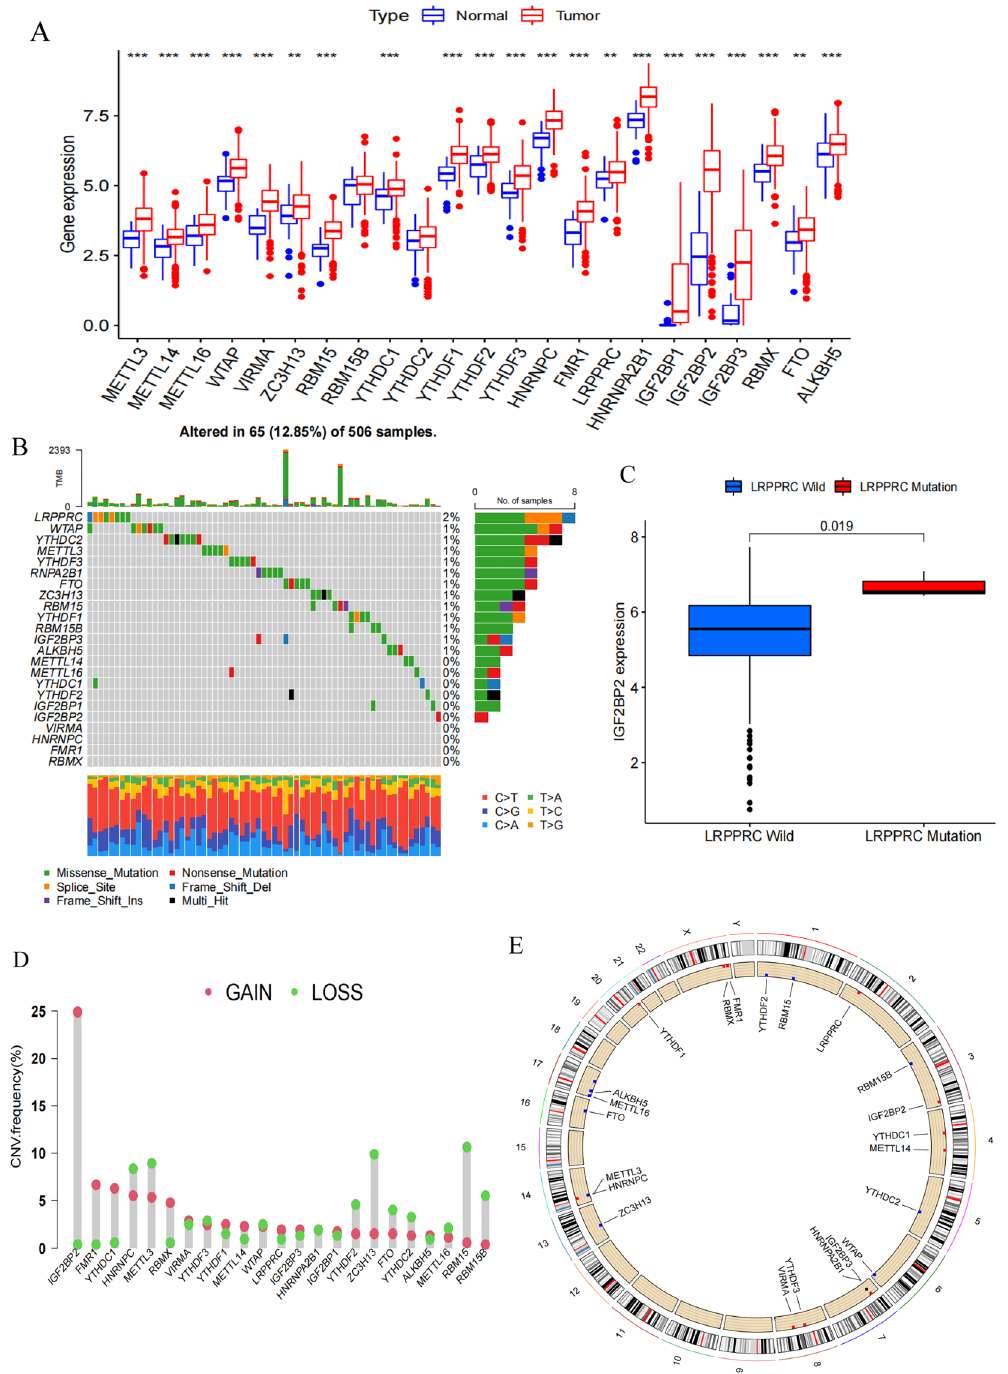
Figure 1. Landscape of genetic and expression variation of m 6 A regulators in OSCC. ( A ) Expression of 23 m 6 A regulator genes between normal tissues and OSCC tissues. Tumor, red; Normal, blue. Top edge of box: upper quartile; bottom edge of box: lower quartile; Internal horizontal line: median. Dots above and below: outliers. *p < 0.05; **p < 0.01; ***p < 0.001. ( B ) Mutation frequency of 23 m 6 A regulator genes in 506 OSCC samples from TCGA database. Each column represented a sample. The upper barplot showed TMB; the lower barplot showed conversion fraction in each sample; the right barplot showed the proportion of each variant type. Number on the right represented the mutation frequency of each regulator gene. ( C ) Differential expression of IGF2BP2 in LRPPRC wild and LRPPRC mutant samples. LRPPRC mutant, red; LRPPRC wild, blue. Top edge of box: upper quartile; bottom edge of box: lower quartile; Internal horizontal line: median. Dots above and below: outliers. The upper number represented p value. ( D ) The CNV frequency of 23 m 6 A regulator genes in TCGA- HNSC cohort. The height of the column represented the CNV frequency. The deletion frequency, blue dot; the amplification frequency, red dot. ( E ) The CNV location of 23 m 6 A regulator genes on